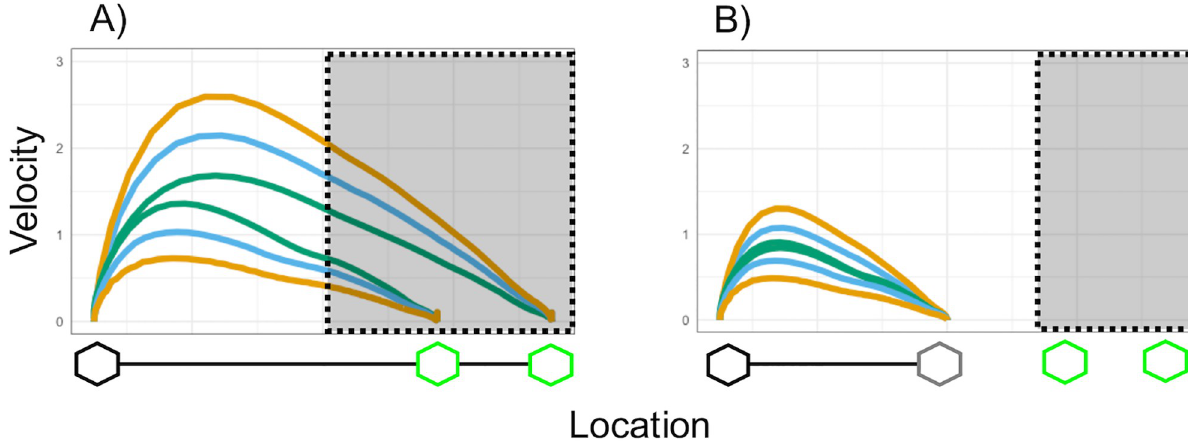
Fig 2. Velocity profiles of sliding movements. Velocity profiles of sliding movements used in the (A) Proximal goal condition and the (B) Distal goal condition. Normal movements are colored in green, Exaggerated movements in blue, and Very exaggerated ones in yellow. The dotted areas represent the occluded areas in each condition during experimental